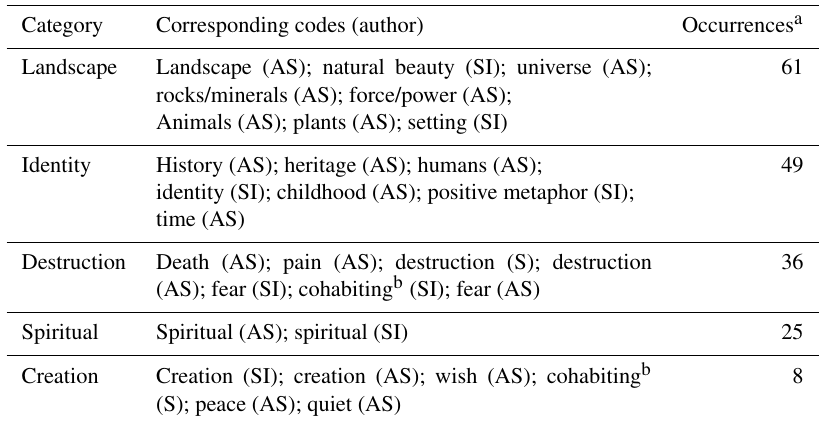
Table 3. The categories that emerged from the coding process, alongside their corresponding codes, and arranged according to the number of times they occurred (AS: Arianna Soldati; SI: Sam